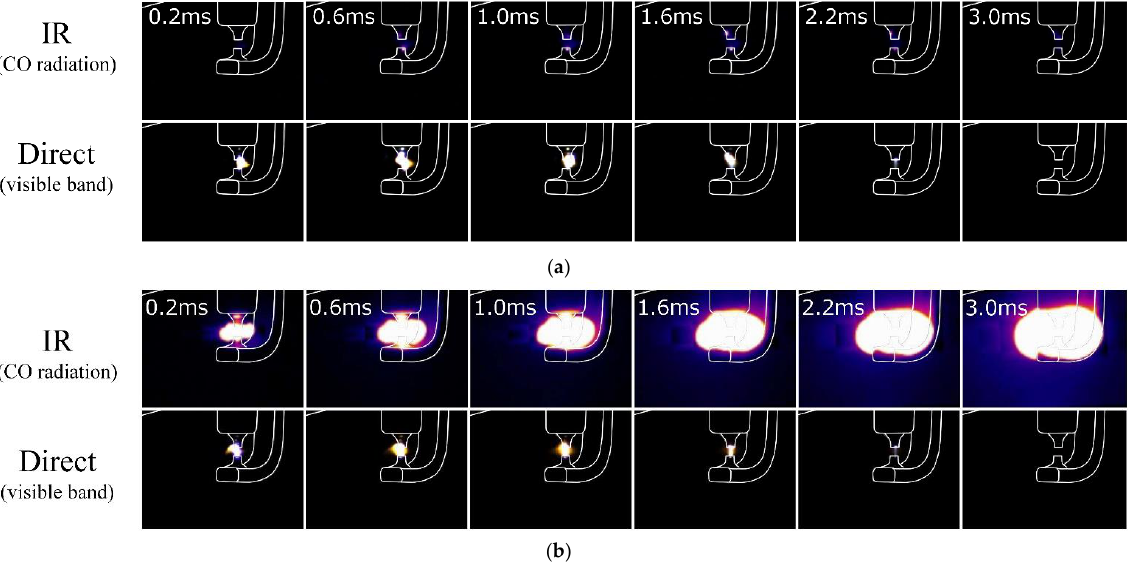
Figure 5. Direct and CO radiation images on static fields with/without fuel conditions (top: CO ra- diation images (aim to detect the initial flame kernel)/lower: direct images (aim to capture the discharge channel)). ( a ) With no fuel condition; ( b ) With fuel condition. discharge channel). ( a ) With no fuel condition; ( b ) With fuel